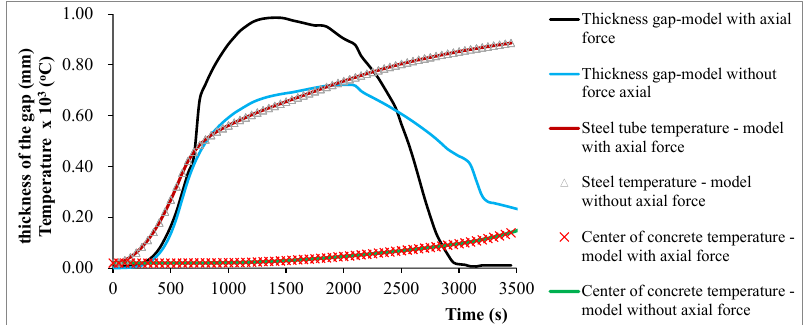
Figure 14. Evolution of the gap and temperature over